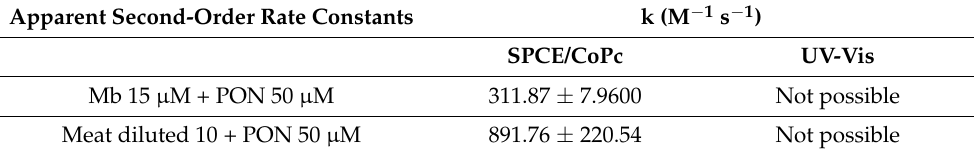
Table 5. Calculated second-order decay rates constants for PON, in PBS pH 9 (0.1M), at 25 ◦ C, determined using classical UV-Vis method at 302 nm and the FIA-EC method, using the SPCE/CoPc (Method